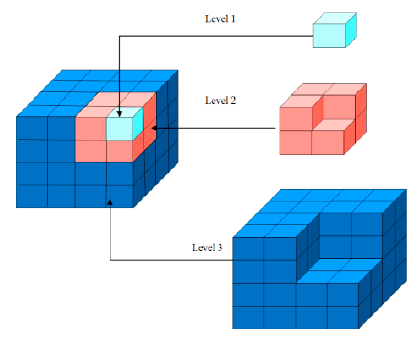
Figure 1. Differential-storage-enhanced octree model.